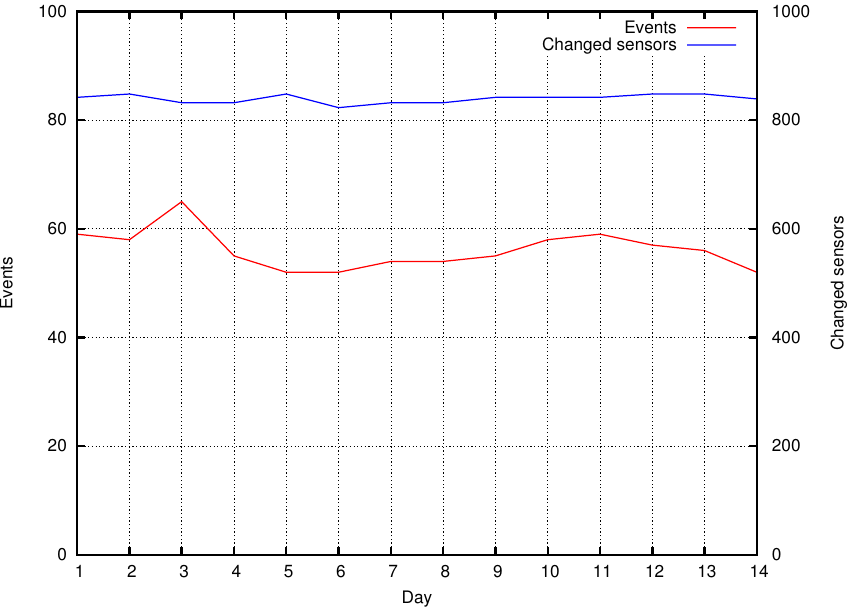
Figure 13. Detected events and number of sensors that will change priority.